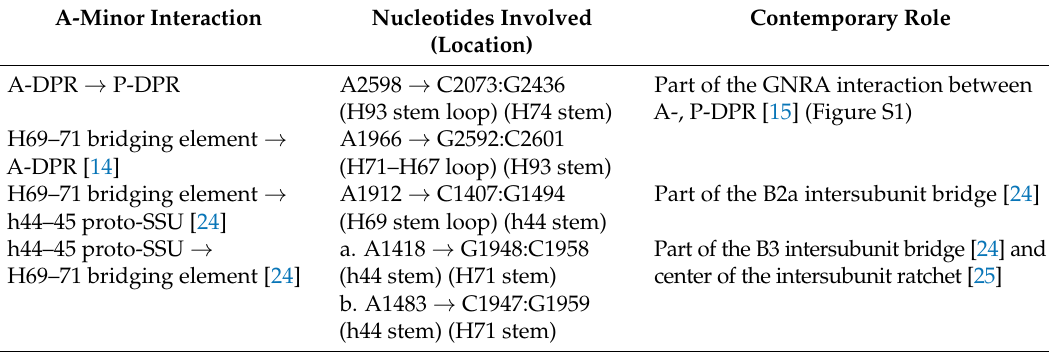
Figure 5. A model of the initial translation system. Three types of ribosomal building blocks forming a simple coded proto-ribosome: 1. A-, P-DPR monomers (blue and green, respectively) 2. H69–71 bridging element (dark red) 3. the h44–45 proto-SSU (purple), which are complemented by tRNA molecules (cyan) interacting with mRNA (orange) and with the PTC pocket (PDB code 1VY4). For clarity, only A-site tRNA is shown. Table 1. A-minor interactions between the building blocks of the coded proto-ribosomal model.